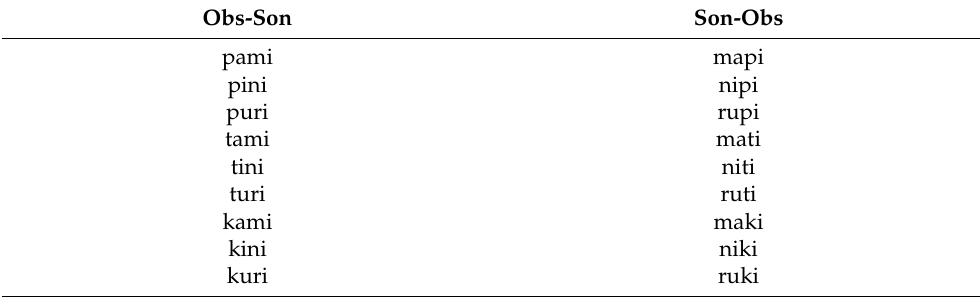
Table 1. The list of stimuli for English speakers (Experiment 1).